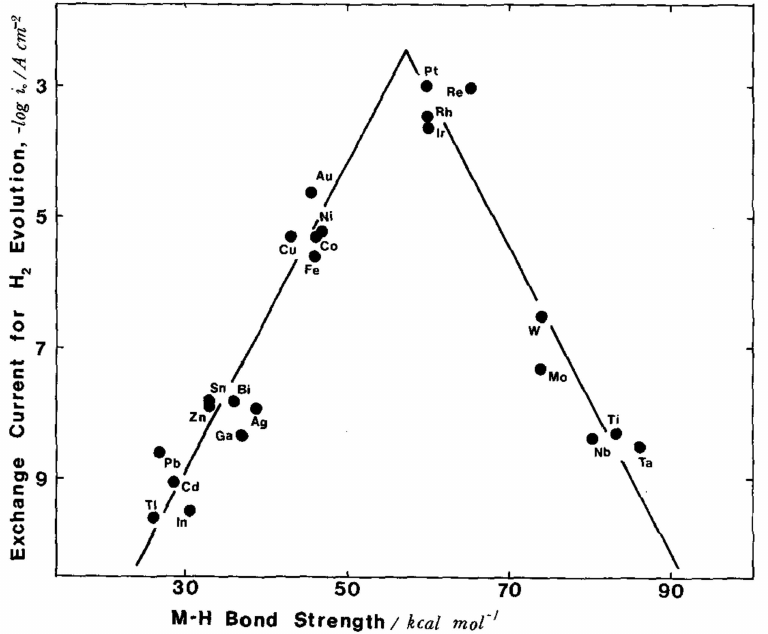
Figure 6. Volcano plot for the hydrogen evolution reaction as a function of the M-H bond strength [46]. (Reprinted with permission from